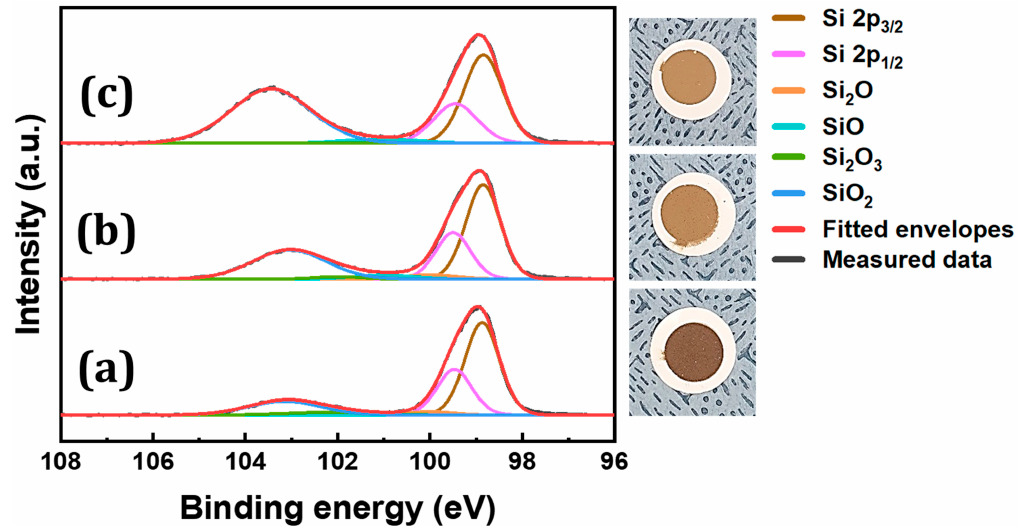
Figure 3. XPS spectra and digital photographs of SiO x NPs synthesized at voltages of ( a ) 7.5 V, ( b ) 10.0 V, and ( c ) 12.5 V at a constant temperature of 5 °C.